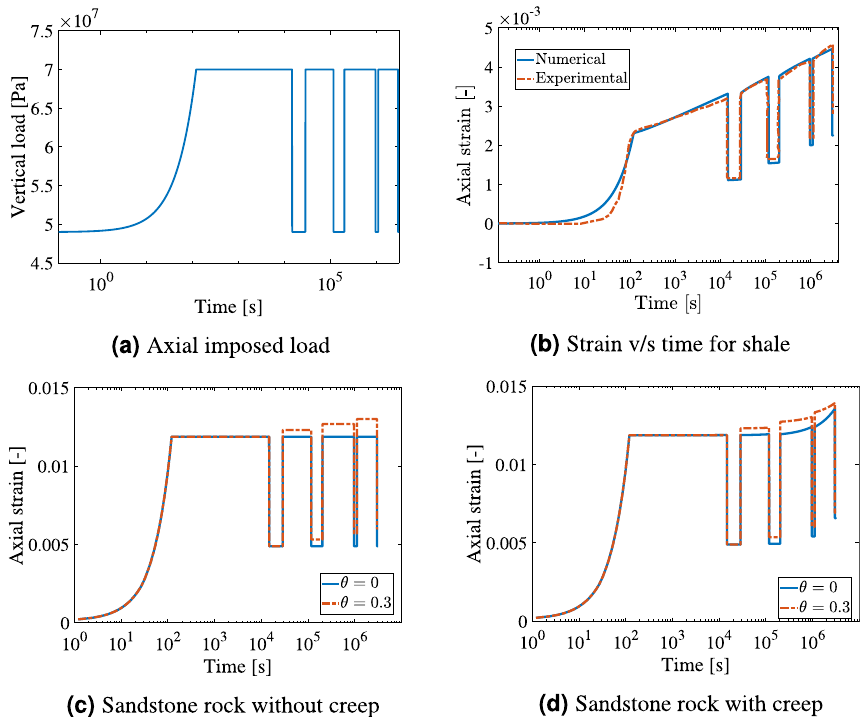
Figure 7. Cyclic loading: illustration of the effect of the imposed cyclic load (Fig. 7 a ) on shale rock and sandstone rock is presented here. The model parameters are chosen from the literature 46 and compared with the experimental data 41 as shown in Fig. 7 (b) . Figure 7 (c , d) show the variation of axial strain for sandstone rock without and with creep deformation for the same imposed loading respectively.